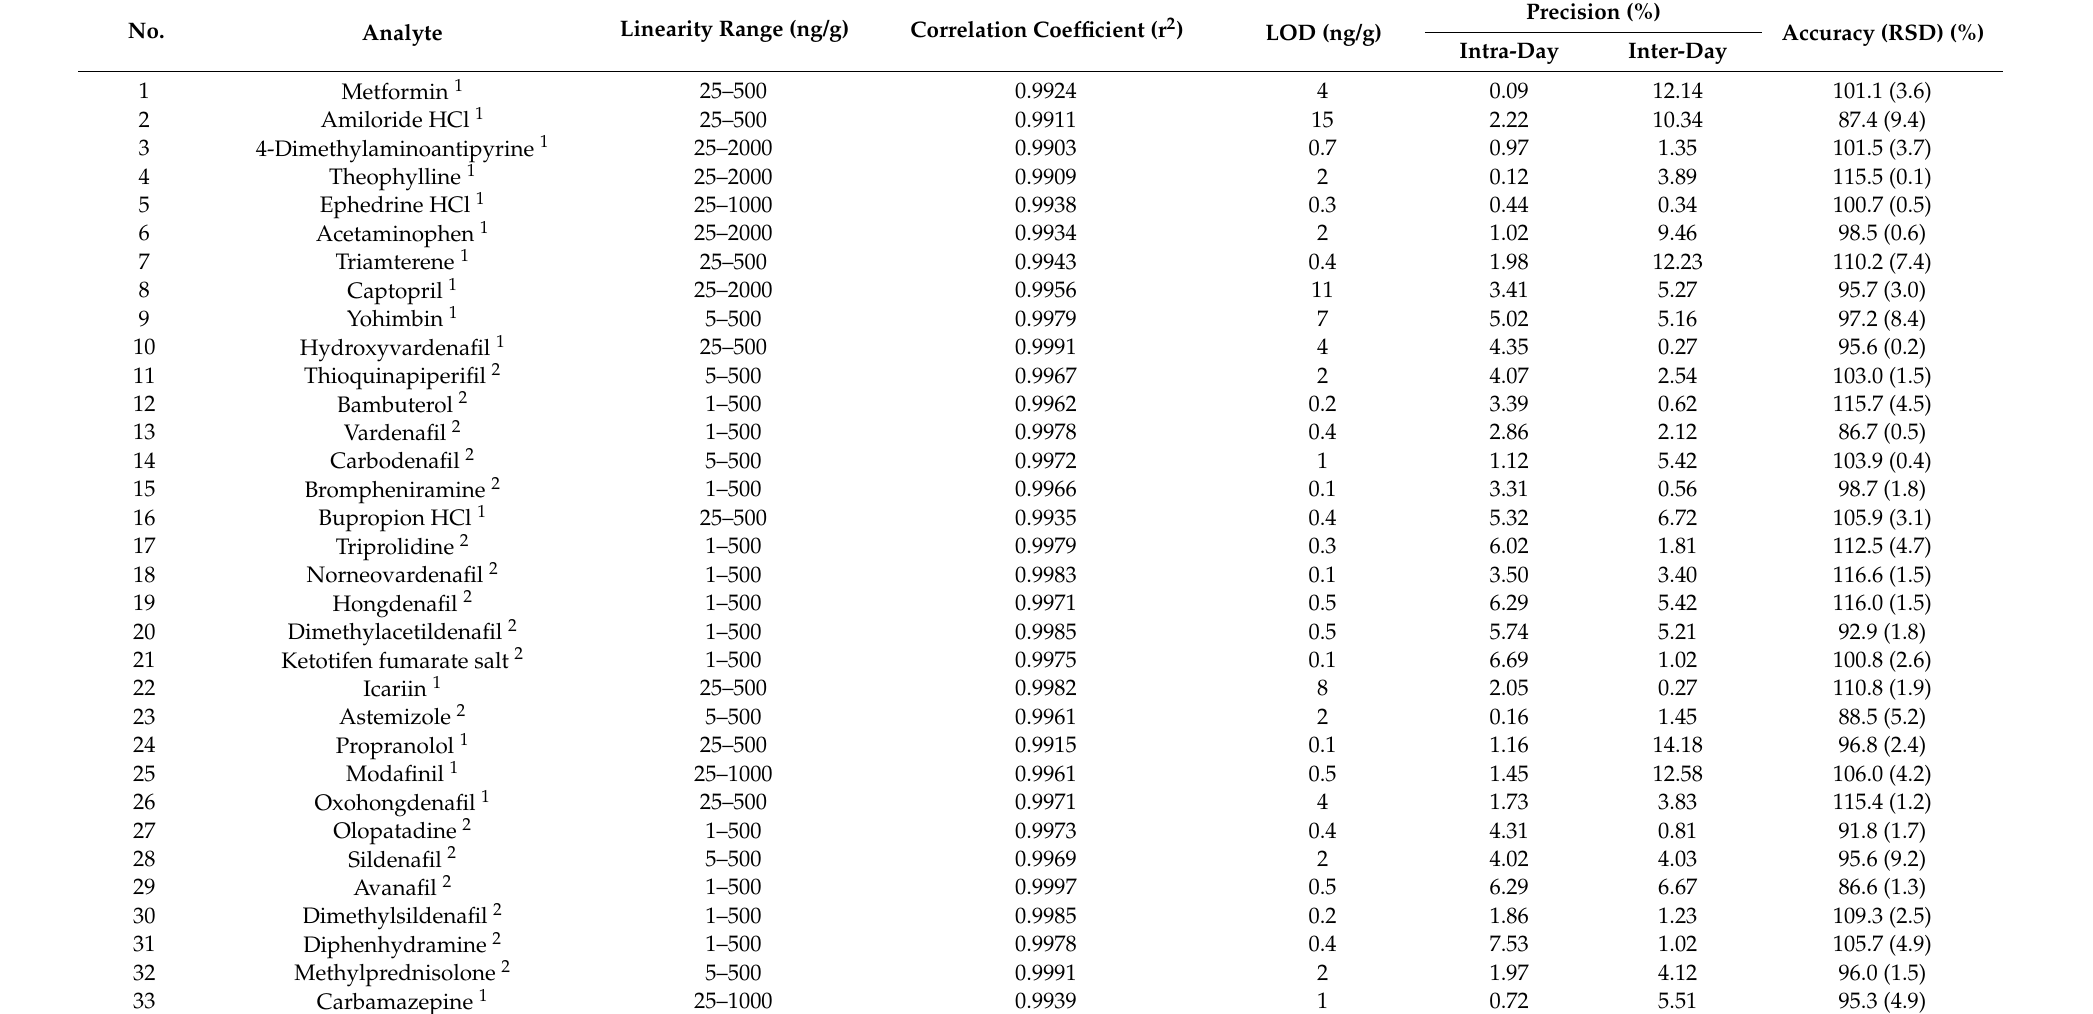
Table 2. Method validation results of 92 illegal adulterants obtained by